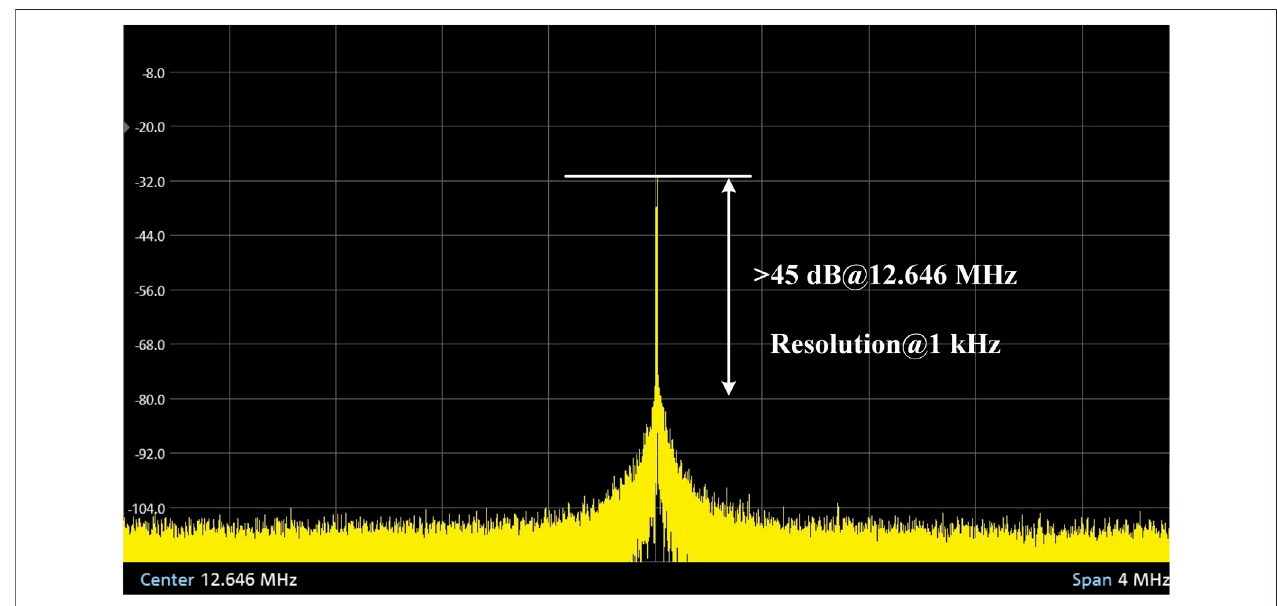
FIGURE 9 | RF spectrum at a fundamental frequency of 12.646 MHz with 1 kHz resolution. The unit of the vertical axis is dBm.